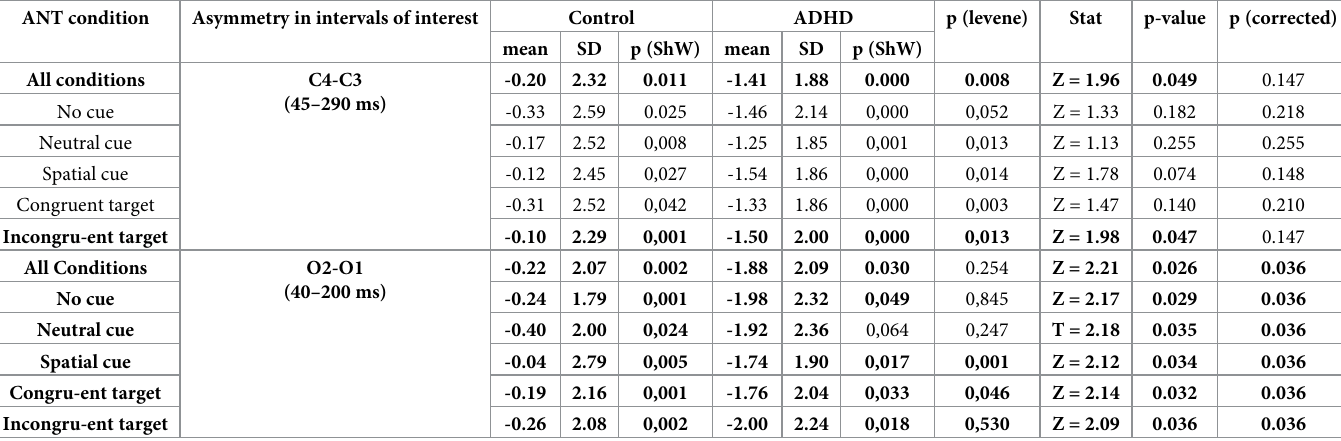
Table 4. Comparisons of interhemispheric asymmetry (mean amplitude) between